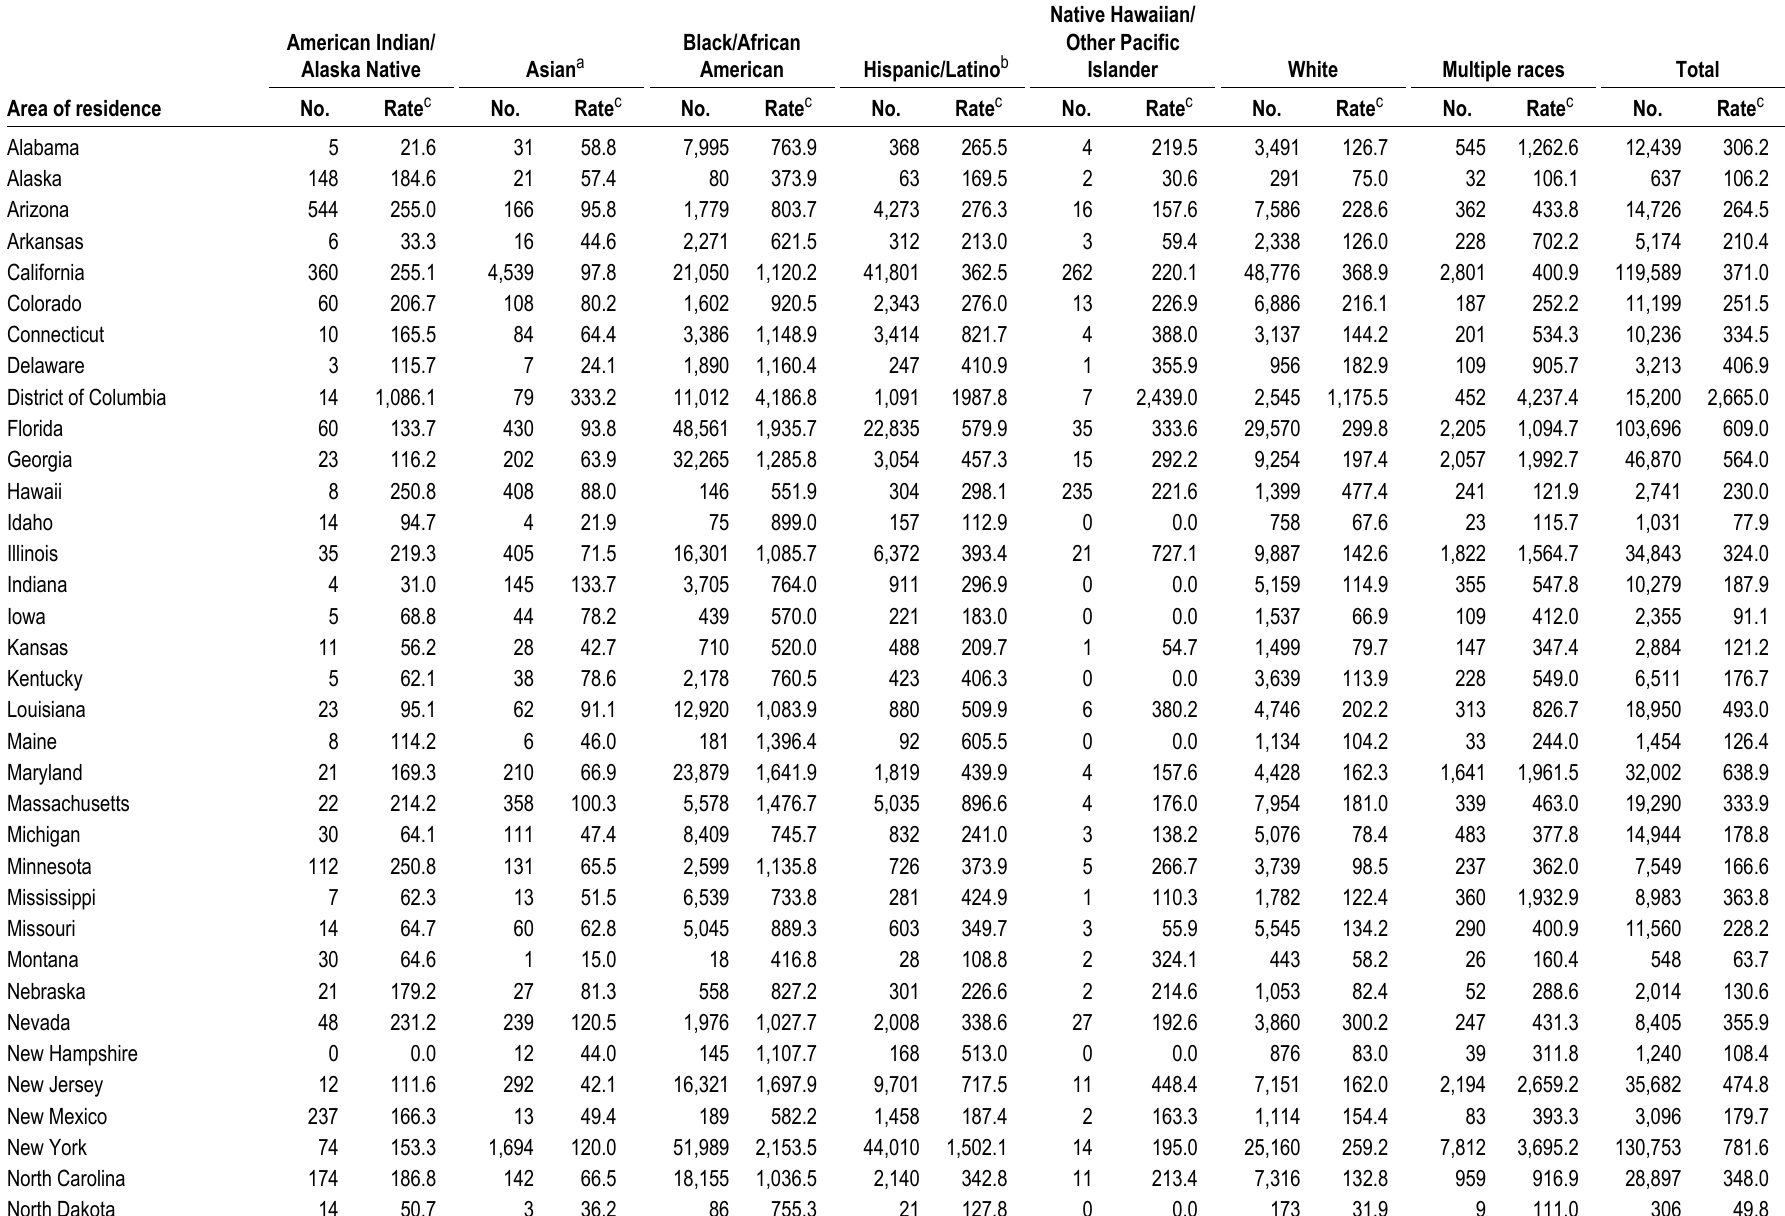
Table 24. Adults and adolescents living with diagnosed HIV infection, by race/ethnicity and area of residence, year-end 2014—United States and 6 dependent areas Native Hawaiian/ American Indian/ Black/African Other Pacific Alaska Native Asian a American Hispanic/Latino b Islander White Multiple races Total